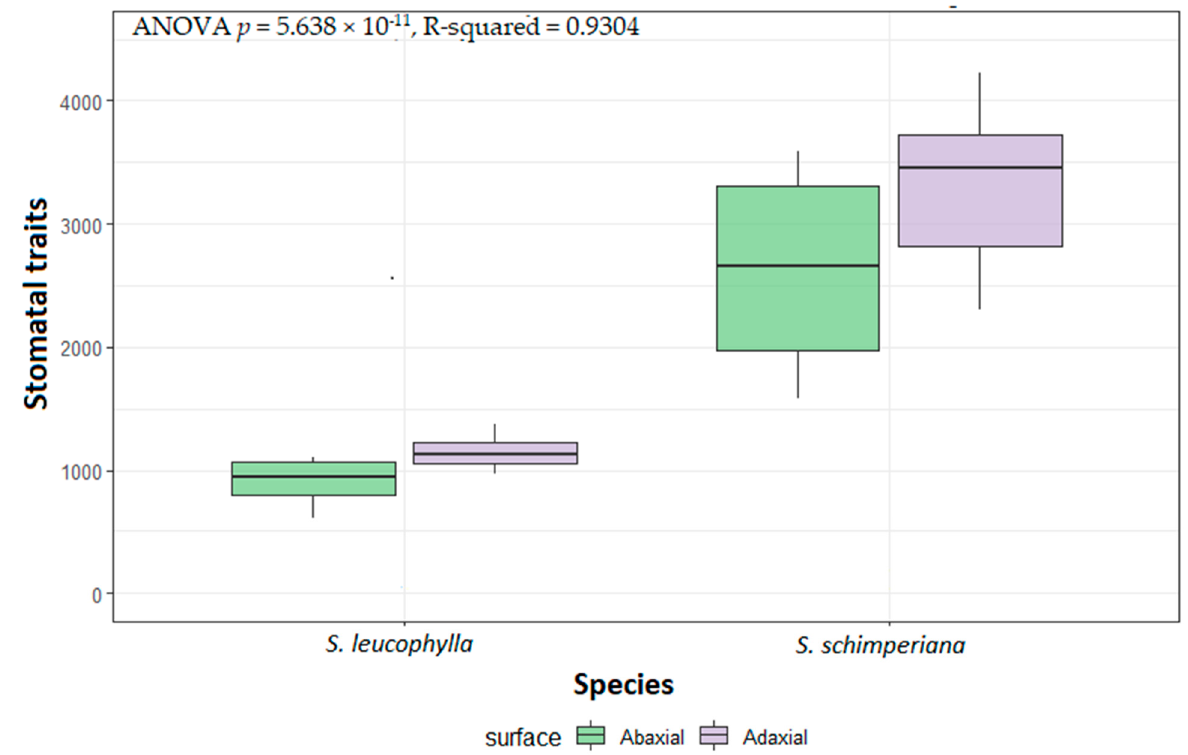
Figure 5. Boxplots of the quantitative data of complex stomatal characteristics, subsidiary cells and stomatal pore measurements of Silene leucophylla and Silene schimperiana .